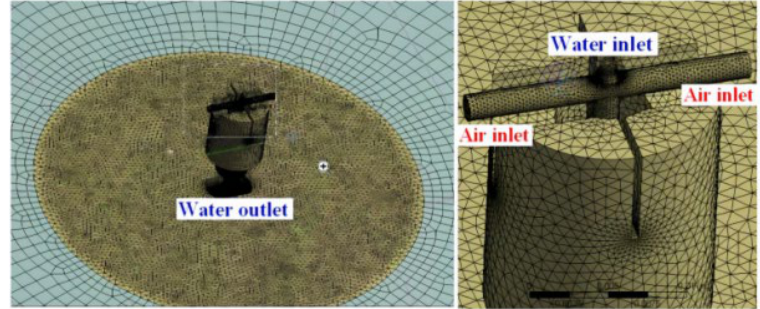
Figure 8. Grid encryption processing results.